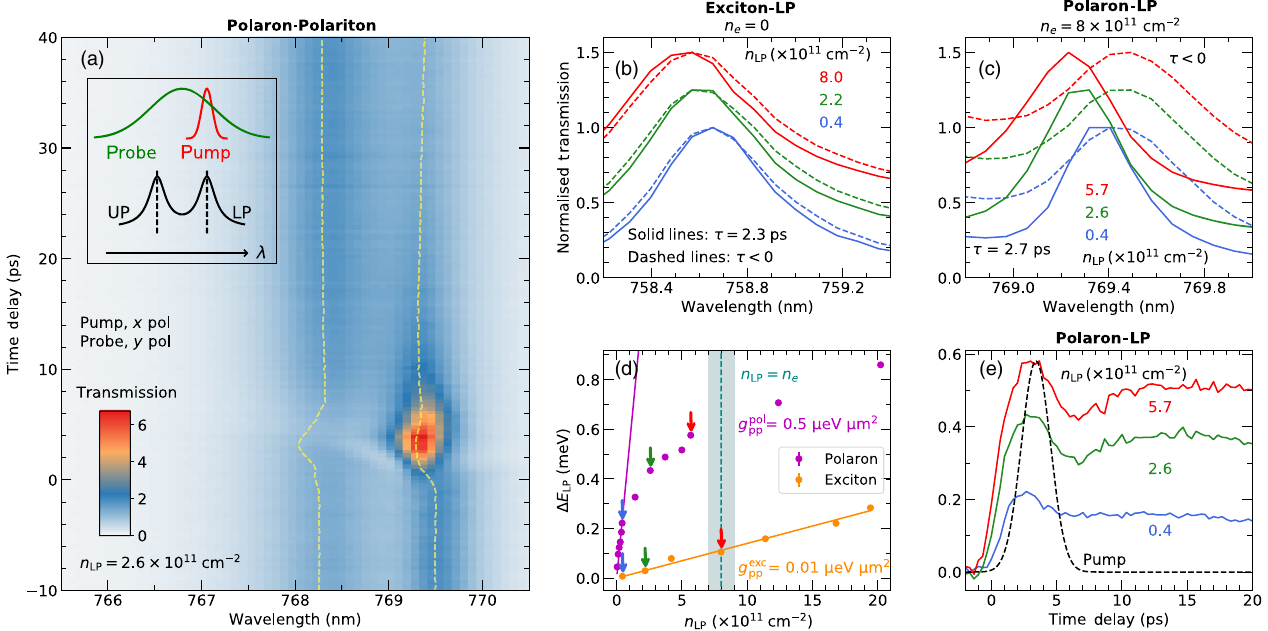
FIG. 2. Blueshift of the lower polariton due to interactions. (a) A typical time delay scan of the probe transmission spectrum from a linear cross-polarized pump-probe experiment. In this case, the polaron-lower-polariton (LP) is resonantly pumped. Inset: An illustration of the energy level scheme of the upper and lower polariton (UP and LP) branches and the pump and probe fields. The pump field is spectrally narrow and tuned in resonance to the LP while the probe field is spectrally broad and covers both branches. Yellow dashed lines show the evolution of UP and LP resonance wavelengths as a function of time delay. (b) Normalized probe transmission ¼ 8 , 2.1, and 0 . 4 × 10 11 cm − 2 . An offset has spectrum of the exciton-LP under resonant pumping for various polariton densities n LP been added for clarity. Solid lines are the probe transmission spectrum measured at τ ¼ 2 . 7 ps. Dashed lines are the average τ < 0 probe transmission spectrum obtained by taking the mean of the transmitted signal at a given wavelength over 5 different negative time delay ¼ 5 . 7 , 2.6, and 0 . 4 × 10 11 cm − 2 . (d) Energy shift of the values. (c) Analogous to (b) but for the polaron-LP at polariton densities n LP exciton- and polaron-LP at τ ¼ 2 . 7 ps measured with respect to τ < 0 as a function of pump power. Blue shaded area indicates the regime where polariton density and electron density are comparable in the system. The error bars are too small to be visible in the plot. For example, for the points indicated by the red arrows, the error bars are 4 and 9 μ eV for the energy shift of the polaron and the exciton, respectively. (e) Evolution of the LP energy shift as a function of time delay. There is a contribution from coherent polaritons at short timescales and one from incoherent polarons at longer timescales. Black dashed line indicates the arrival of the pump pulse as determined in an independent measurement (see Appendix